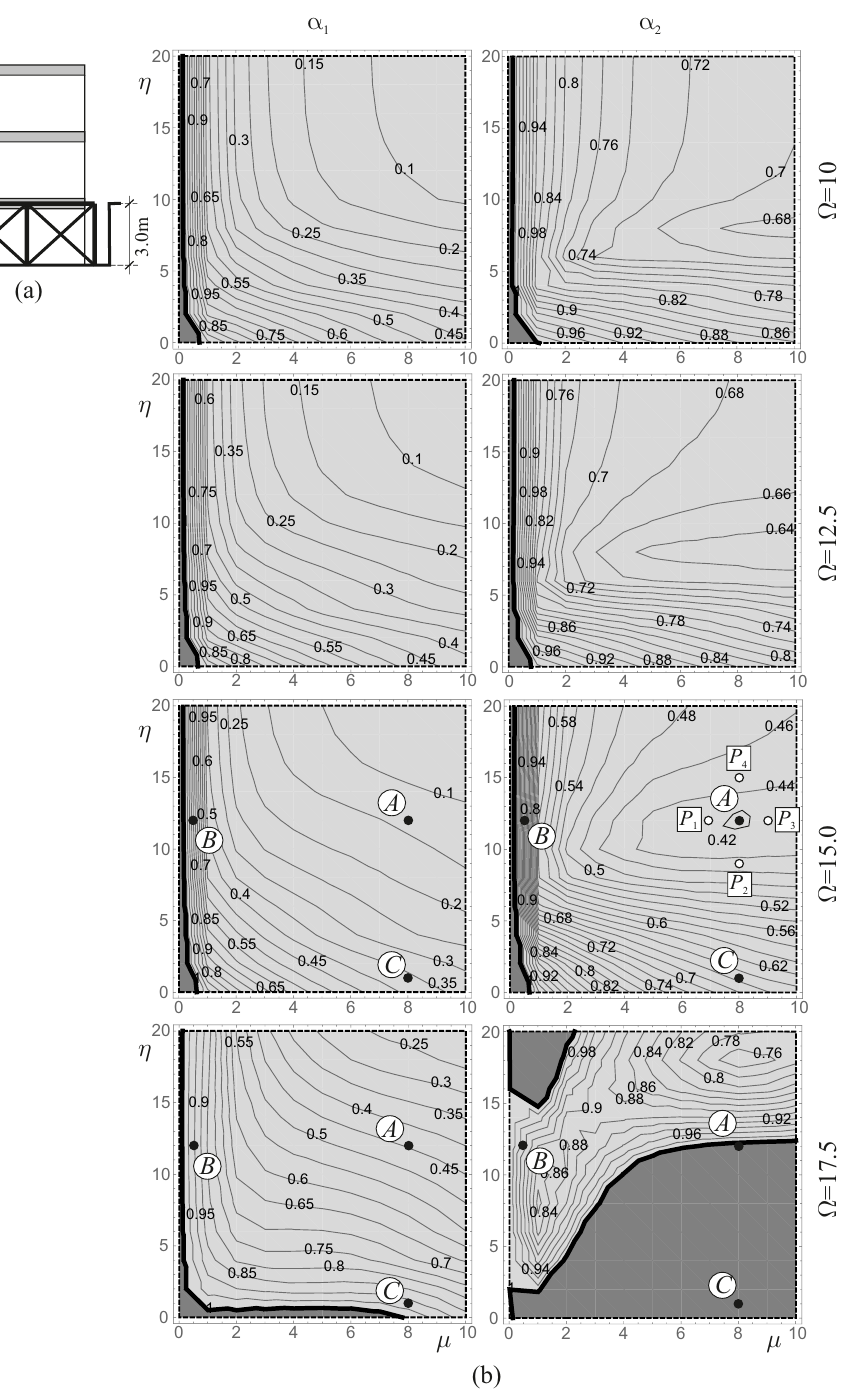
Figure 3. Gain maps: ( a ) geometric coupling scheme; ( b ) Gain maps α 1 and α 2 for different frequencies Ω of the harmonic excitation ( ψ = 0.1, γ = 0.1, A reference cases examined in the